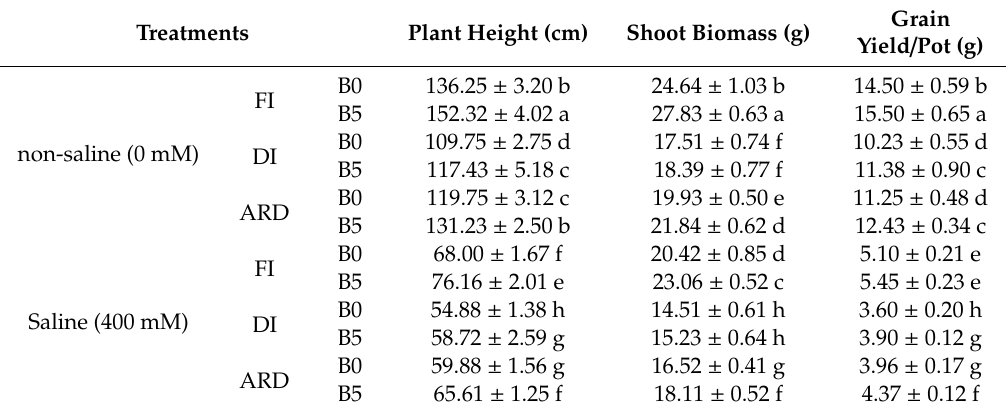
Table 2. Growth and yield of quinoa as a ff ected by biochar, irrigation regimes, and salinity. Treatments